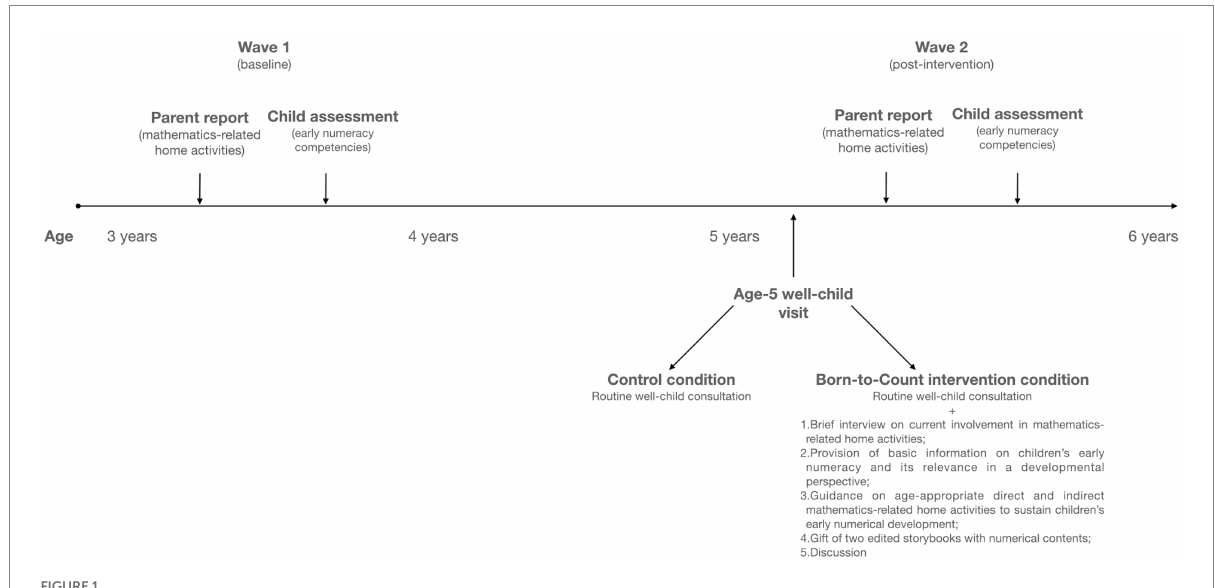
FIGURE 1 Timeline of data collection waves in the Born-to-Count